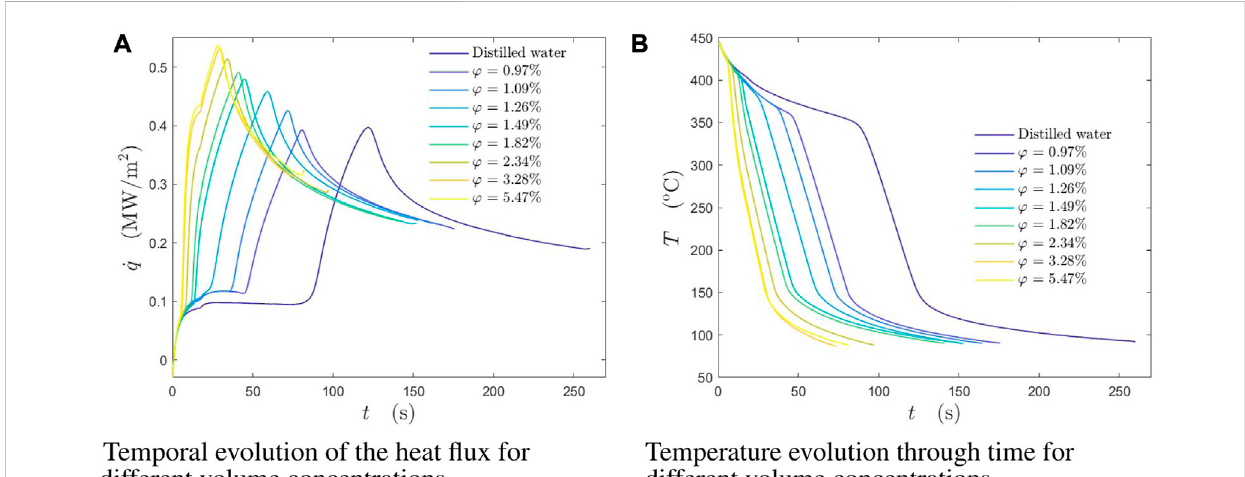
FIGURE 5 (A) Temporal evolution of the heat fl ux for different volume concentrations. (B) Temperature evolution through time for different volume concentrations. Temperature and heat fl ux at the spray and target axis at the wall surface as a function of time during spray cooling for different volume concentrations of lubricant solutions. Initial wall temperature was T w0 = 445 ° C. The spray parameters are: the mean drop diameter D 10 = 78.7 μ m, the mean impact velocity U =14.05 m/s and the mass fl ux _ m (cid:1) 2 . 50 ± 0 . 03 kg/m 2 s. The corresponding datasets are in the Electronic Supplementary Material